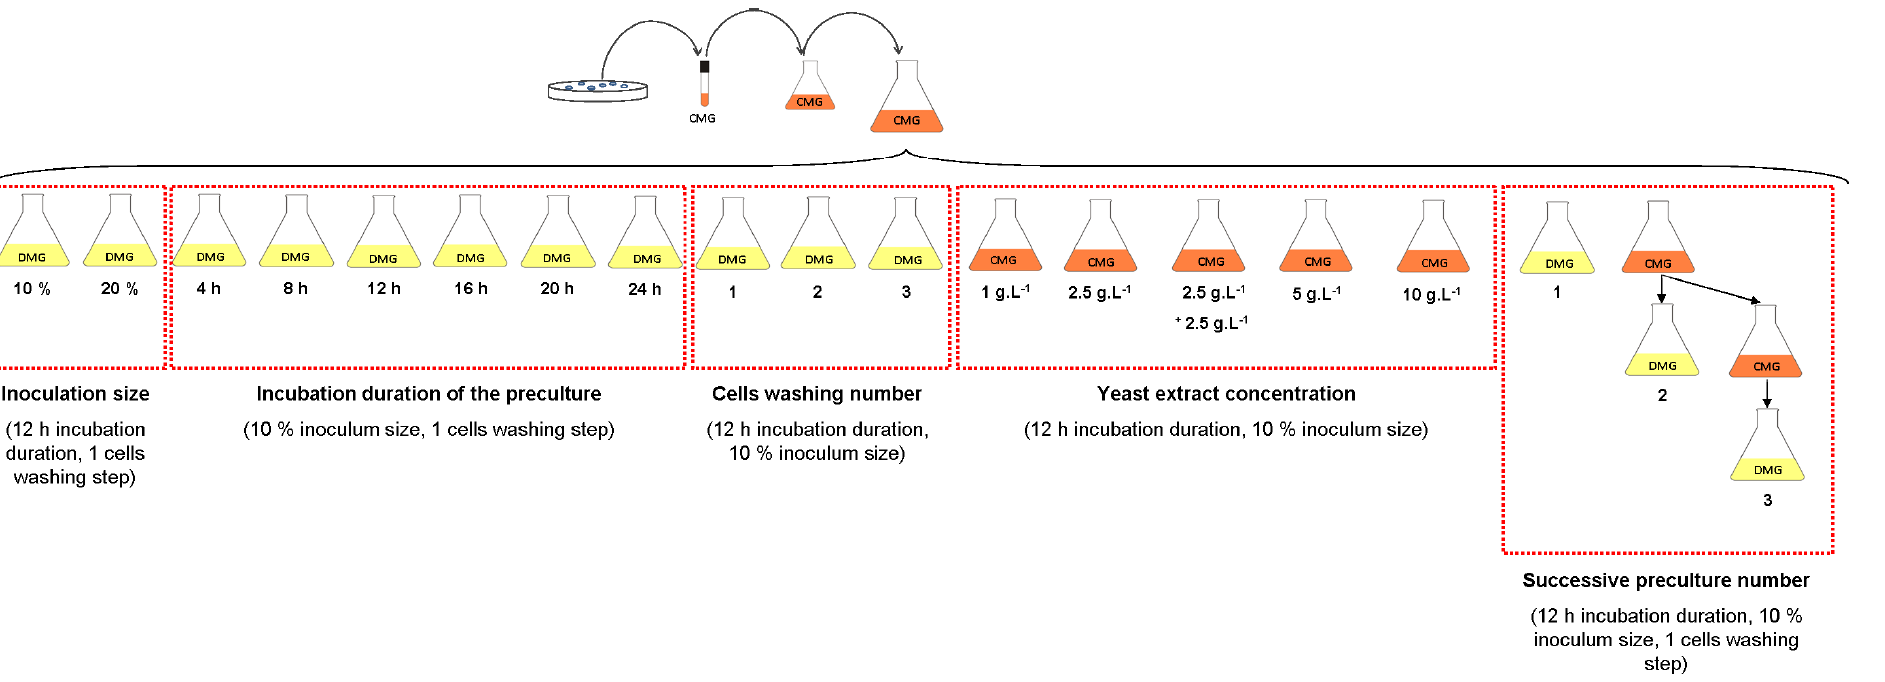
Figure A1. Description of the protocol for the experiments on yeast extract concentration, inoculation size, incubation duration of the preculture, cell washing number and number of precultures, in baffled Erlenmeyer